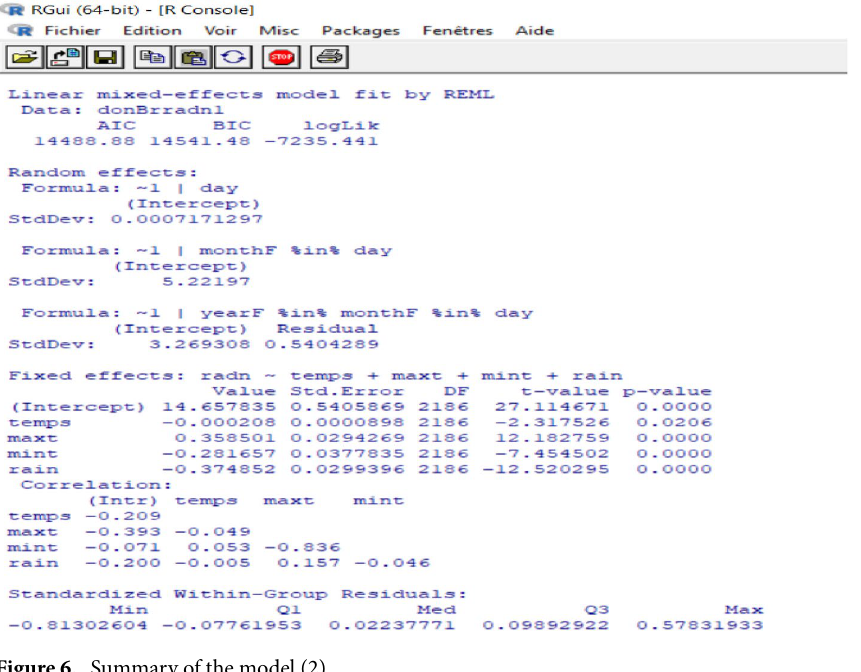
Figure 6. Summary of the model (2).